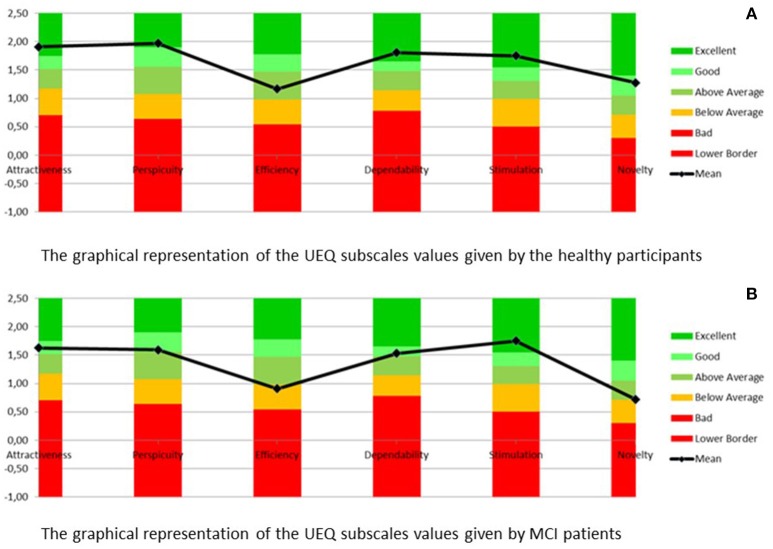
(A) The graphical representation of the UEQ subscales values given by the healthy participants and (B) the graphical representation of the UEQ subscales values given by MCI participants.